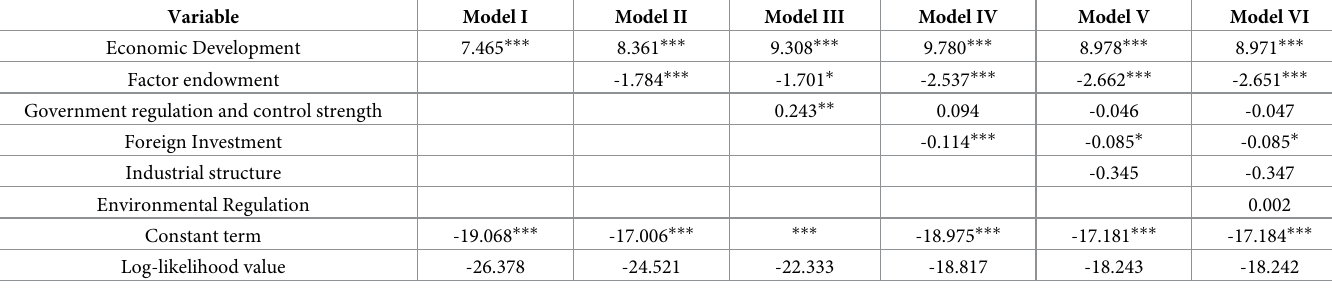
Table 6. Regression analysis results of Tobit